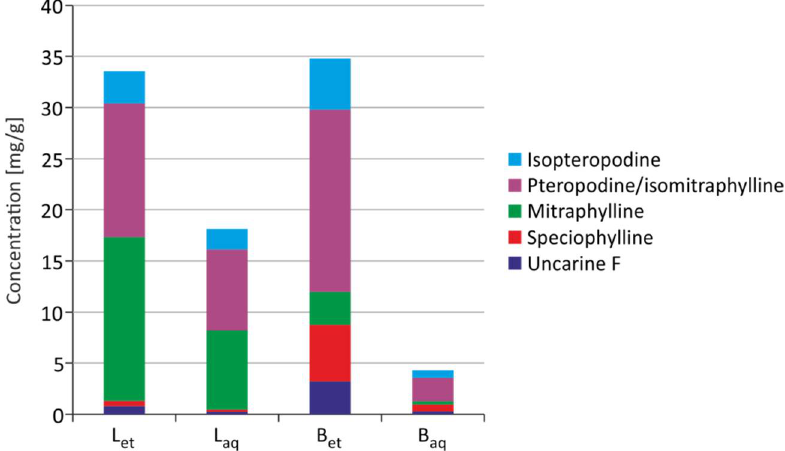
Figure 5. Content of alkaloids in the extracts from U. tomentosa (B et –ethanolic extract from the bark; B aq –aqueous extract from the bark; L et –ethanolic extract from leaves; L aq –aqueous extract from leaves) [18].